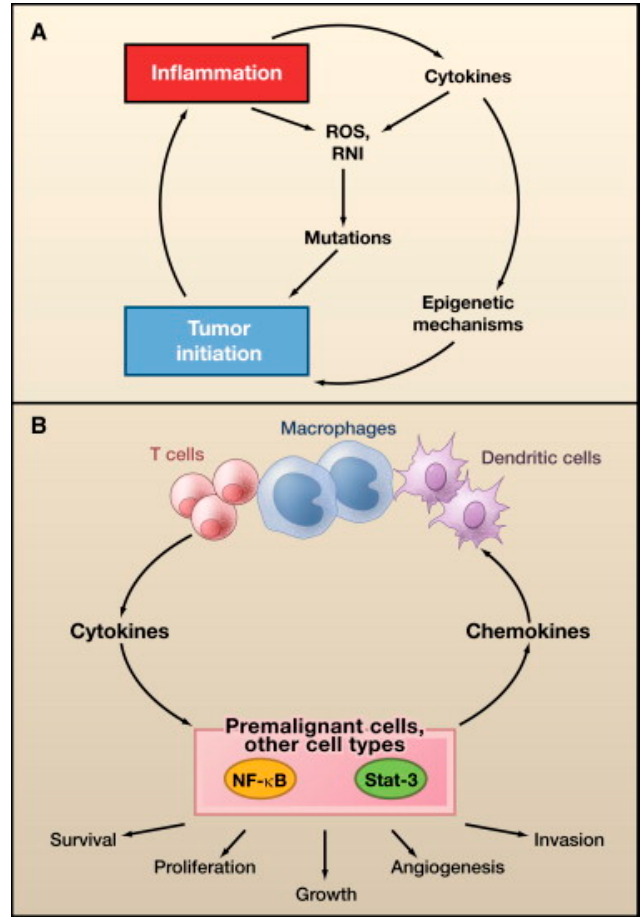
Figure 5. Role of Inflammation in Tumor Initiation and Promotion. ( A ) Tumor initiation. Reactive oxygen species (ROS) and reactive nitrogen intermediates (RNI) produced by inflammatory cells may cause mutations in neighboring epithelial cells. Also, cytokines produced by inflammatory cells can elevate intracellular ROS and RNI in premalignant cells. In addition, inflammation can result in epigenetic changes that favor tumor initiation. Tumor associated inflammation contributes to further ROS, RNI, and cytokine production; ( B ) Tumor promotion. Cytokines produced by tumor-infiltrating immune cells activate key transcription factors, such as NF- κ B or STAT3, in premalignant cells to control numerous protumorigenic processes, including survival, proliferation, growth, angiogenesis, and invasion. As parts of positive feed-forward loops, NF- κ B and STAT3 induce production of chemokines that attract additional immune/inflammatory cells to sustain tumor-associated inflammation. Reproduced with permission from Grivennikov, S.I., Immunity, Inflammation, and Cancer; published by Cell , 2010.